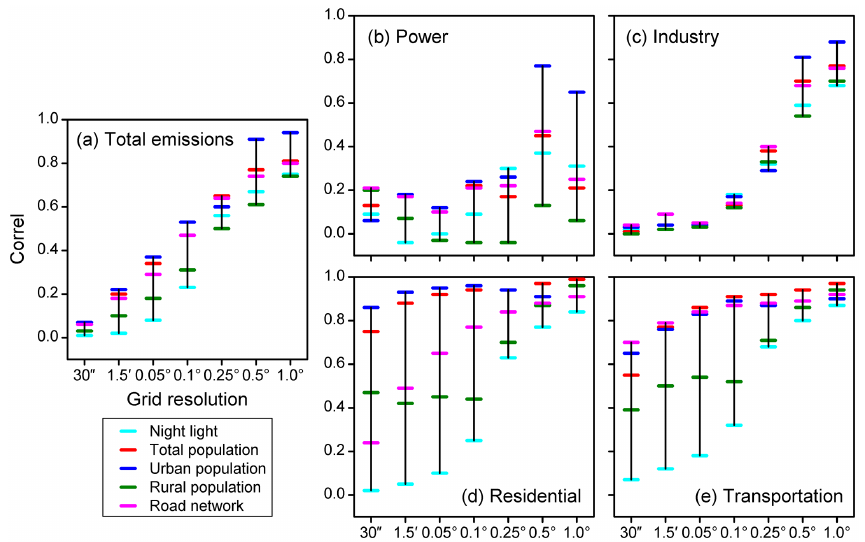
Figure 9. Sector-specific spatial correlation between NO x emissions from HB-EI and allocating proxies spanning resolutions from 30 (cid:48)(cid:48) to